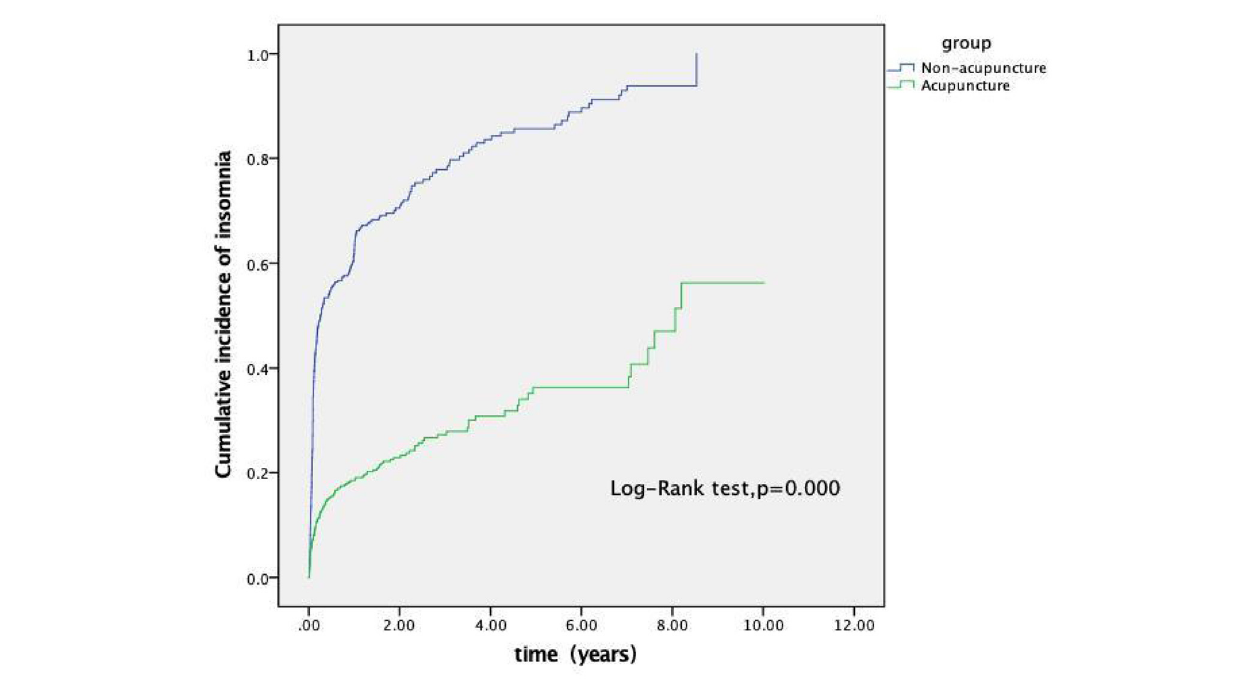
FIGURE 2 | Cumulative incidence of insomnia between the acupuncture and non-acupuncture cohorts of stroke patients. As shown in the figure, the cumulative incidence of the acupuncture cohort was significantly lower than that of the non-acupuncture cohort (log-rank test, p =